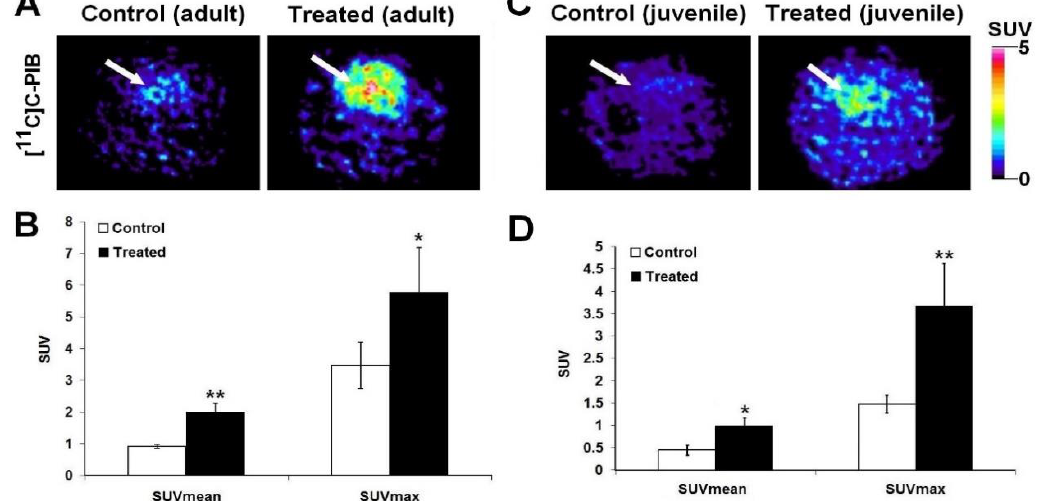
Figure 2. In vivo assessment of the impact of the administered combined (cholesterol and Al 2 (SO 4 ) 3 ) treatment on [ 11 C]C-PIB brain radiopharmaceutical accumulation of both the older and the younger rats using [ 11 C]C-PIB PET examinations. ( A ) Represents the transaxial PET slices of the untreated control ( A left ) and the treated ( A right ) adult group of rats. Panel B demonstrates the results of the quantitative SUV analysis of [ 11 C]C-PIB uptake of the adult control rats, and those receiving treatment. ( C ) Represents the transaxial PET slices of the untreated control ( C left ) and the treated ( C right ) young rats. ( D ) Demonstrates the results of the quantitative SUV analysis of [ 11 C]C-PIB uptake of the young control rats, and those receiving treatment. SUV values are presented as mean ± SD. Significance level (compared to the untreated control group): p ≤ 0.05 (*) and p ≤ 0.01 (**). [ 11 C]C-PIB: [ 11 C]C Pittsburgh compound B; PET: Positron Emission Tomography; SUV: standardised uptake value; SD: standard deviation. White arrow: brain.